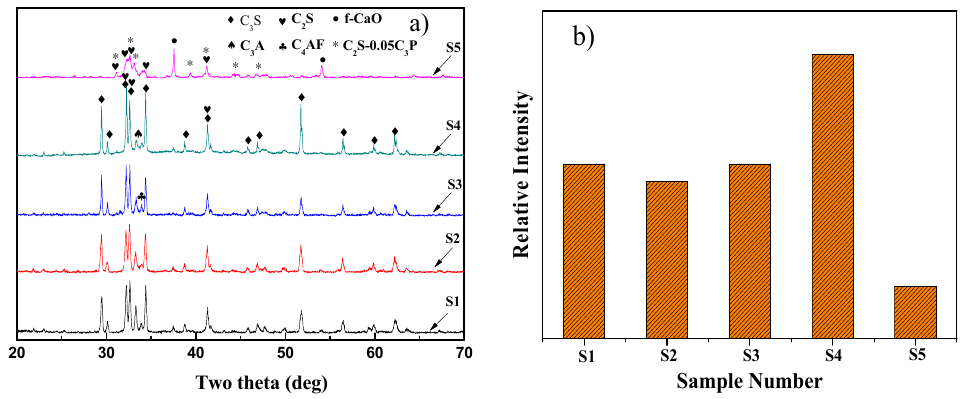
Figure 3. The XRD patterns of the clinker adding with different amount of SS and the peak intensity of C 3 S: ( a ) XRD patterns; and ( b ) comparison of XRD peak intensity at 2 θ range from 31.8° to 32.4°.